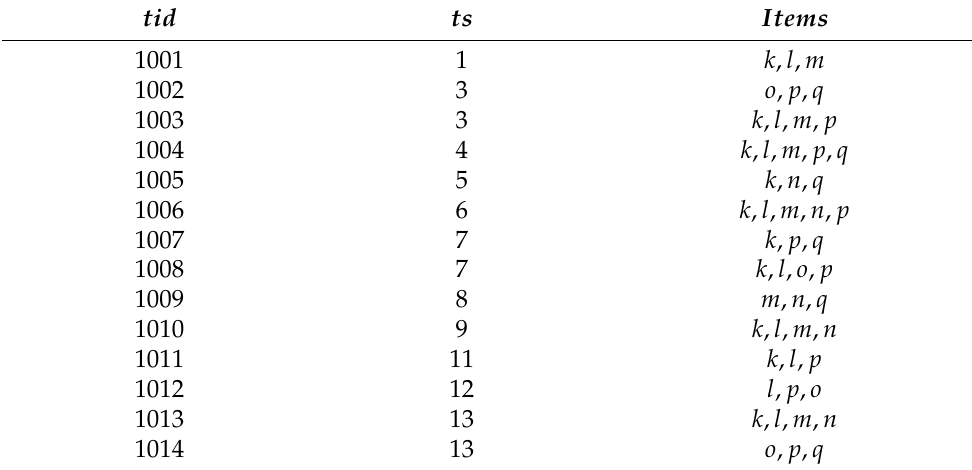
Table 2. The temporal